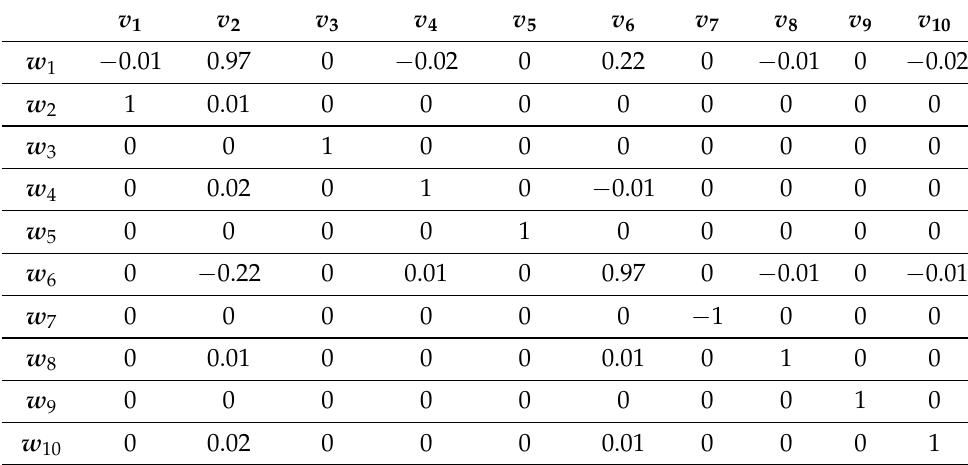
(cid:16) (cid:17) w i , v j Table 2. cos between first ten eigenvectors in W 1 and V 1